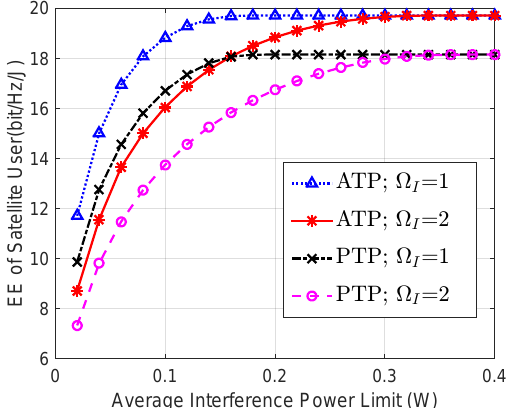
Figure 4. The EEs of the satellite user versus I th with different transmit constraints and interference link conditions with P av = P m = 0.05 W and m I =